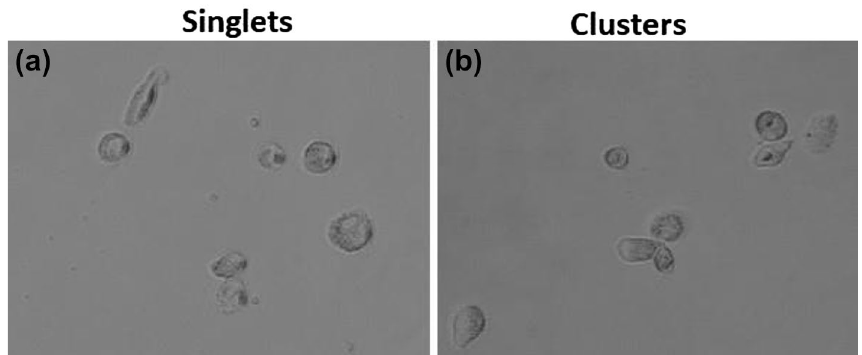
Figure 5. Brightfield images of isolated CTCs. ( a ) CTC singlets and ( b ) CTC clusters were captured and isolated from a breast cancer patient using the ScreenCell device. Images were taken with an inverted microscope (20×).